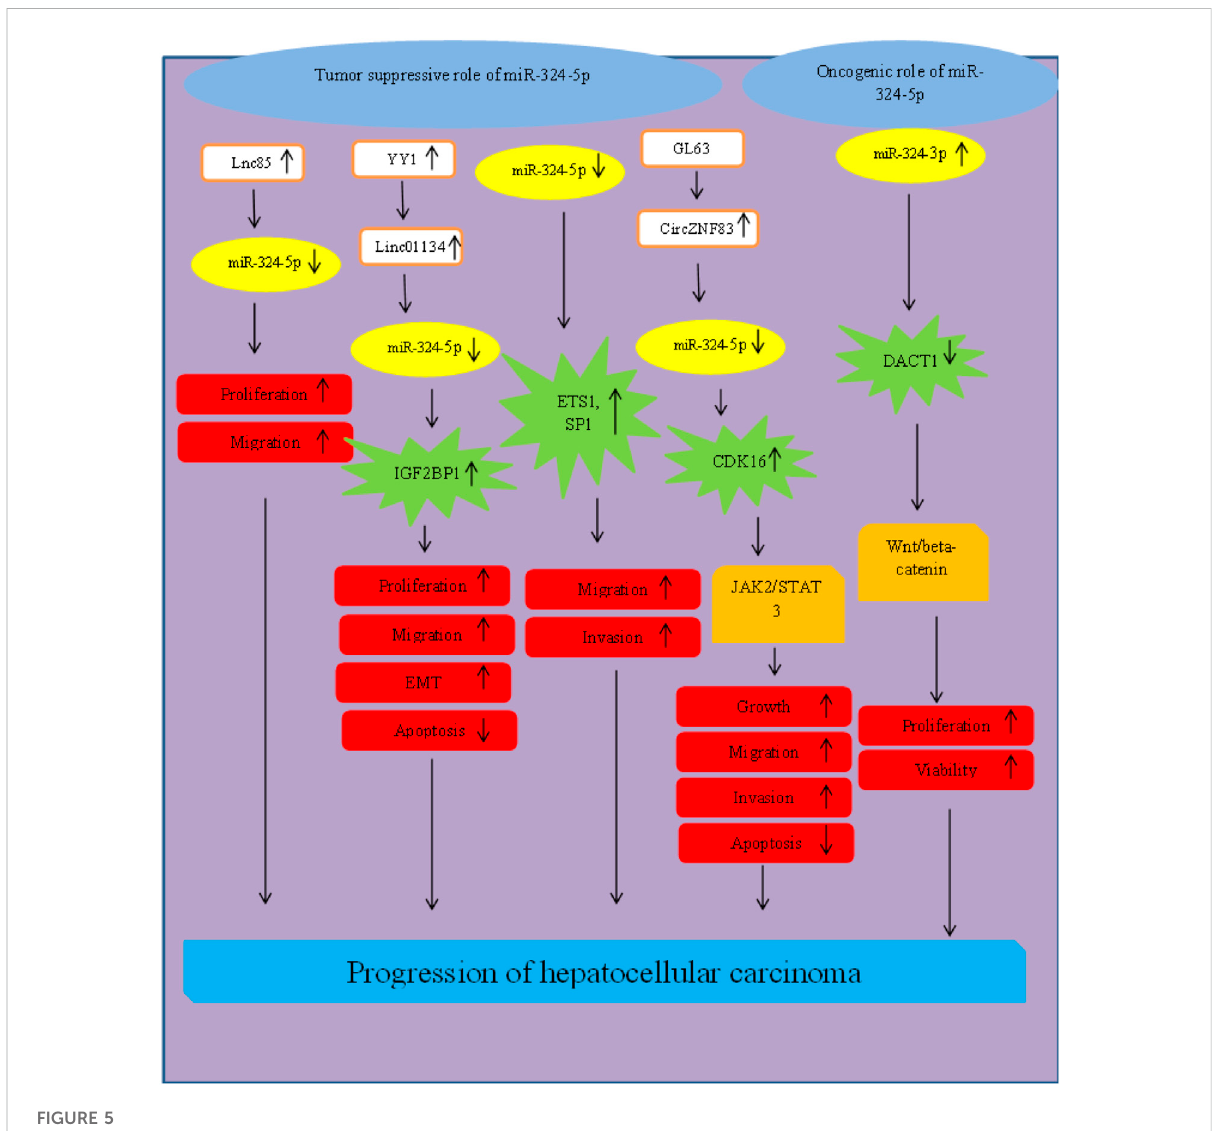
FIGURE 5 Role of miR-324 in progression of hepatocellular